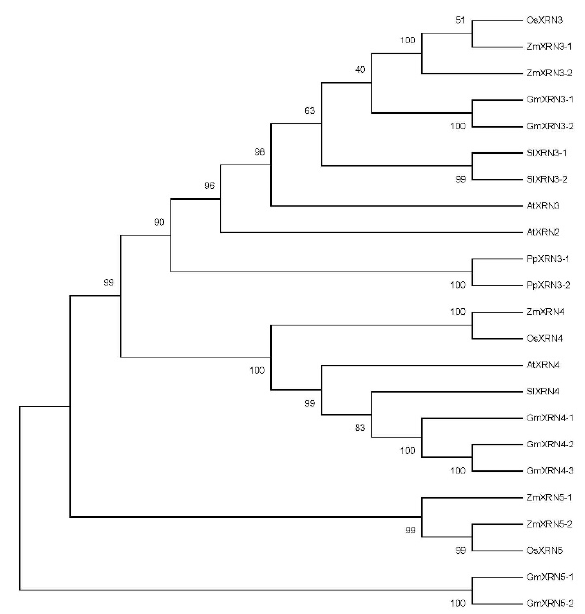
Figure 1. The polygenetic analysis of XRNs in moss, Arabidopsis, tomato, soybean, rice, and maize. The sequences were aligned by ClusterW method, and the polygenetic tree was constructed using the NJ method in MEGA tool with 1000 bootstrap replicates. The numbers above the branches refer to the bootstrap value of the neighbor-joining phylogenetic tree.